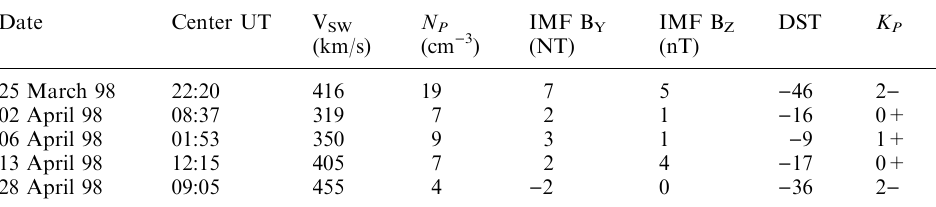
Table 2. Interplanetary and geomagnetic conditions. The solar wind conditions are aver- aged over a 40 min interval, o(cid:128)set from the EDI measure- ments as described in the